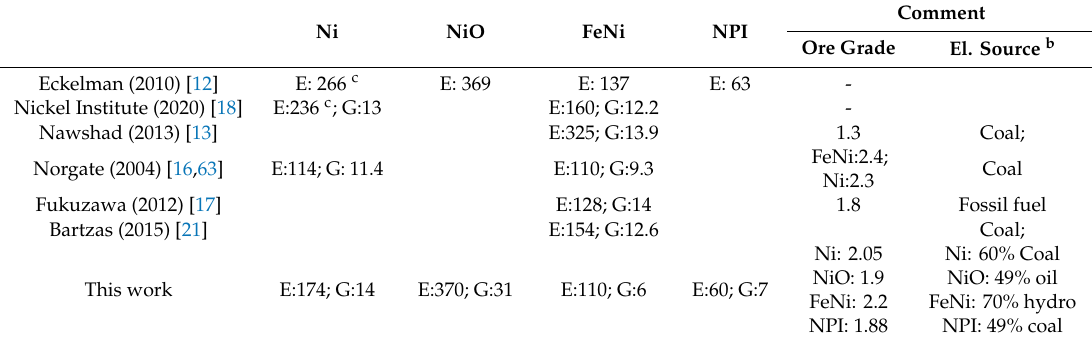
Table 10. Comparisons of energy consumption (GJ / t alloy) and GHG emission (tCO 2 -eq / t alloy) of nickel alloy production a .